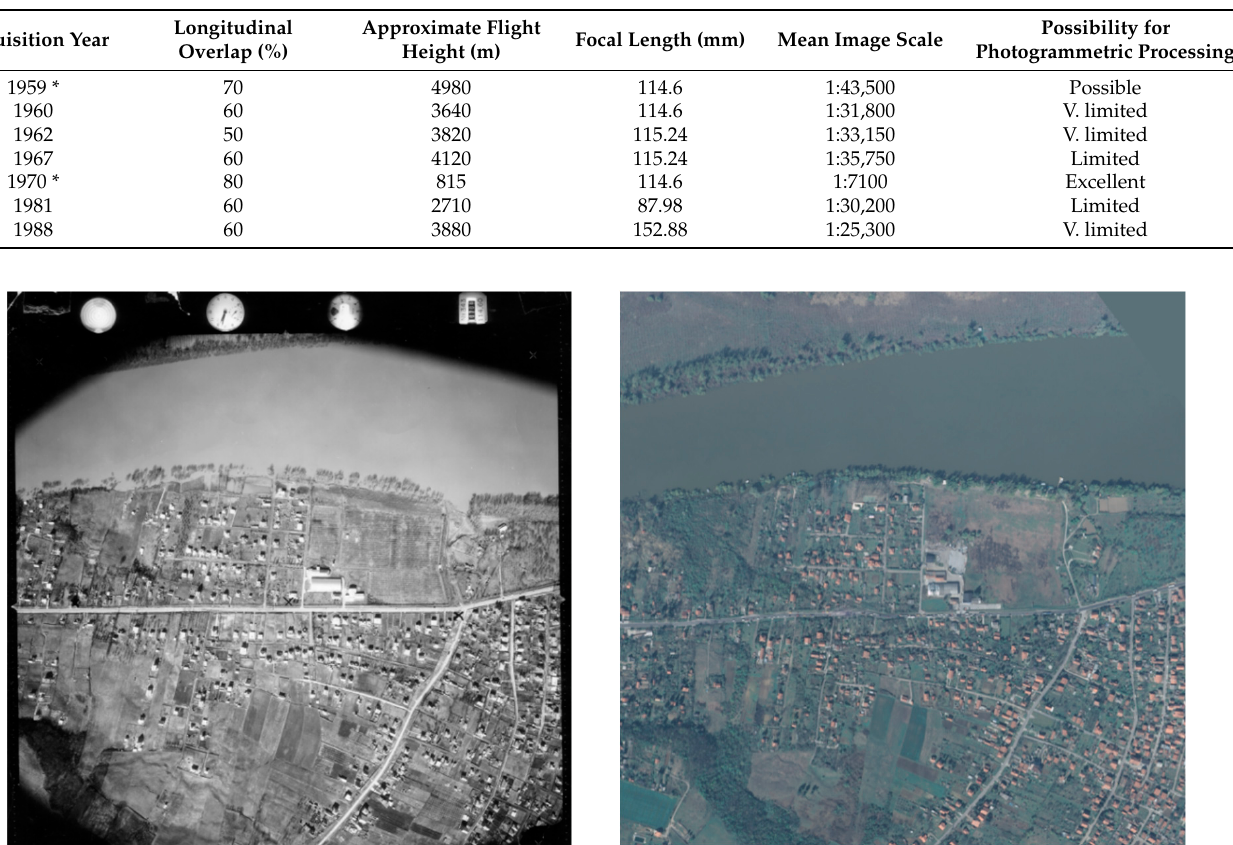
Figure 2. Analog aerial photography of the Umka landslide from 1970 ( left ) and digital photography of the same area from 2007 ( right ).